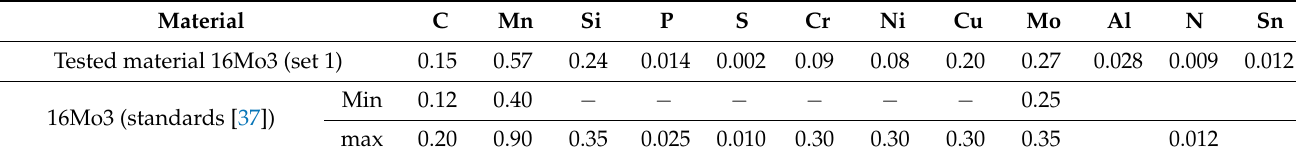
Table A1. Chemical composition of experimentally tested chrome-molybdenum 16Mo3 alloy steel (in % by weight). Material C Mn Si P S Cr Ni Cu Mo Al N Sn Tested material 16Mo3 (set 1) 0.15 0.57 0.24 0.014 0.002 0.09 0.08 0.20 0.028 0.009 0.012 Min 0.12 0.40 − − − − − − 0.25 16Mo3 (standards [37]) max 0.20 0.90 0.35 0.025 0.010 0.30 0.30 0.30 0.35